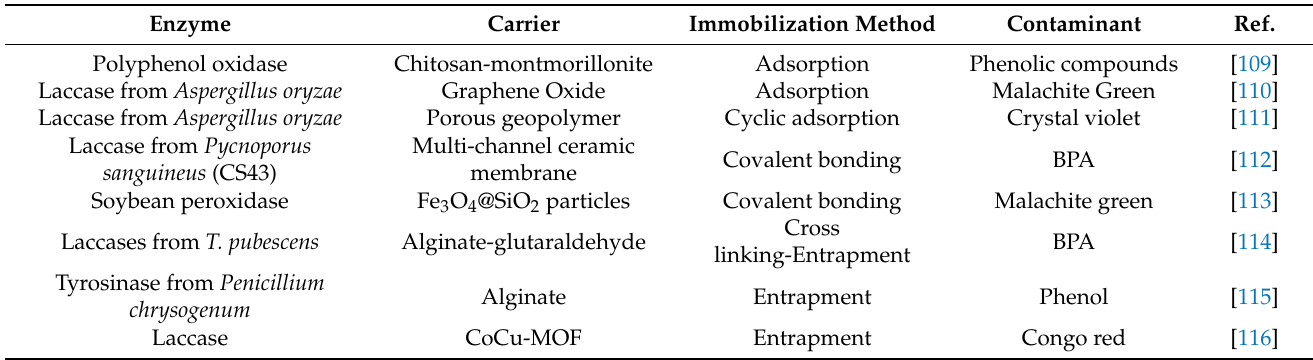
Table 3. Application of immobilized enzyme in the treatment of refractory organics contaminants containedin waste